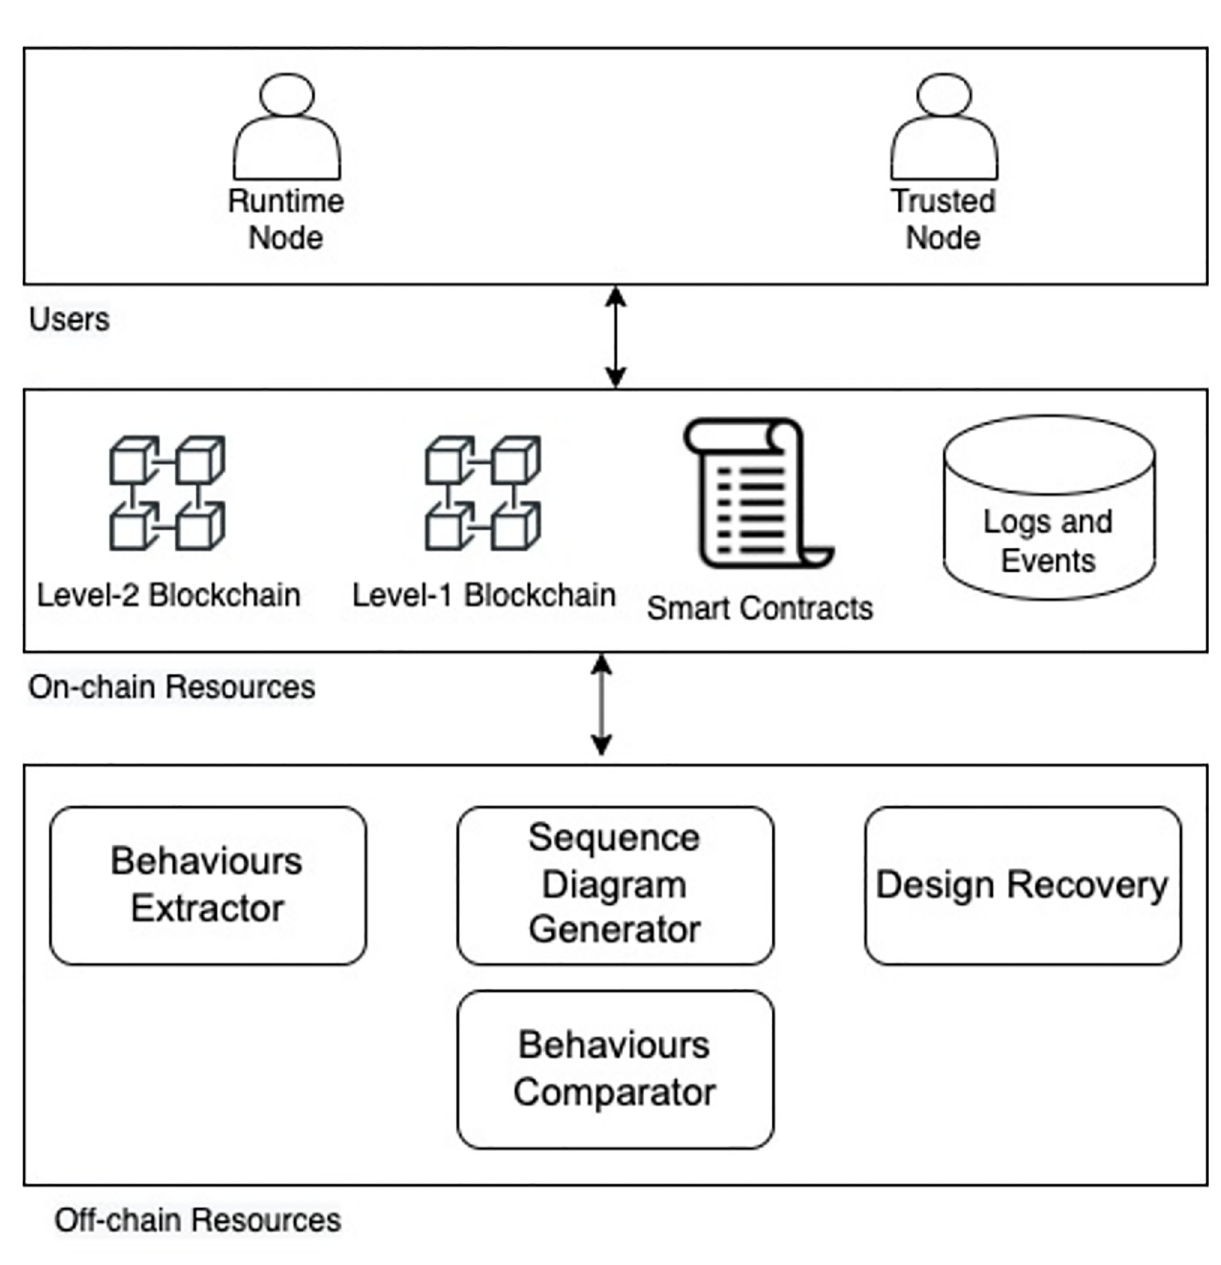
Fig 1. The system